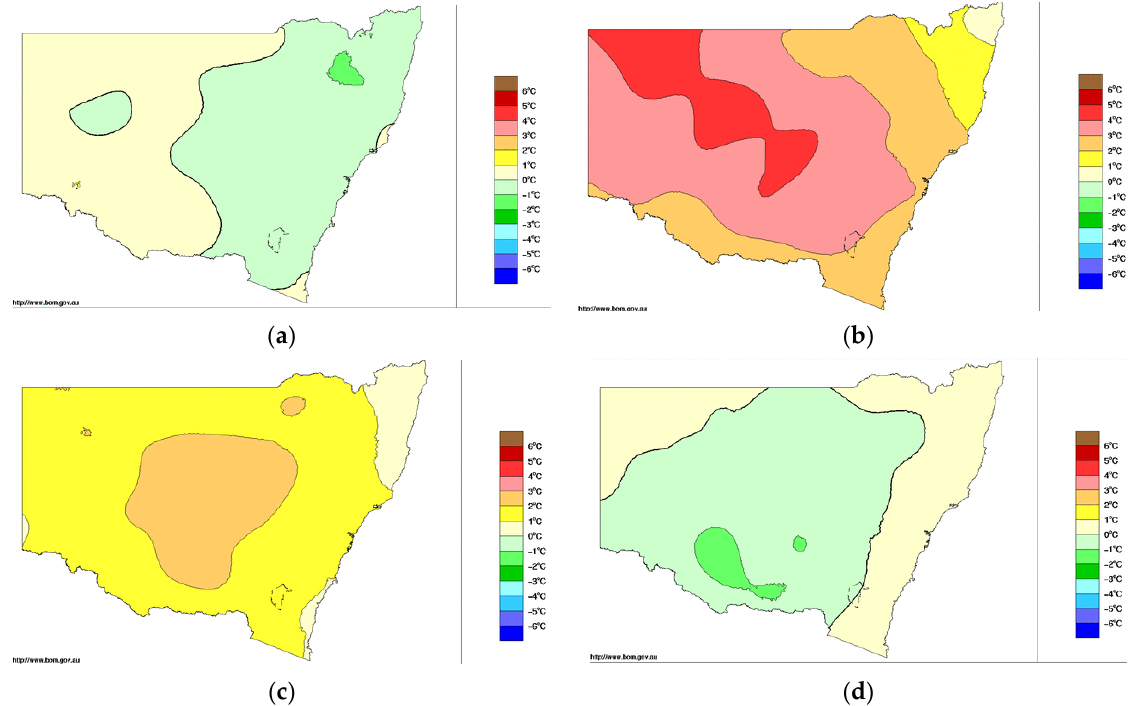
Figure 13. Mean temperature anomaly in NSW for April: ( a ) 2017, ( b ) 2018, ( c ) 2019, and ( d ) 2020. (Adapted with permission from